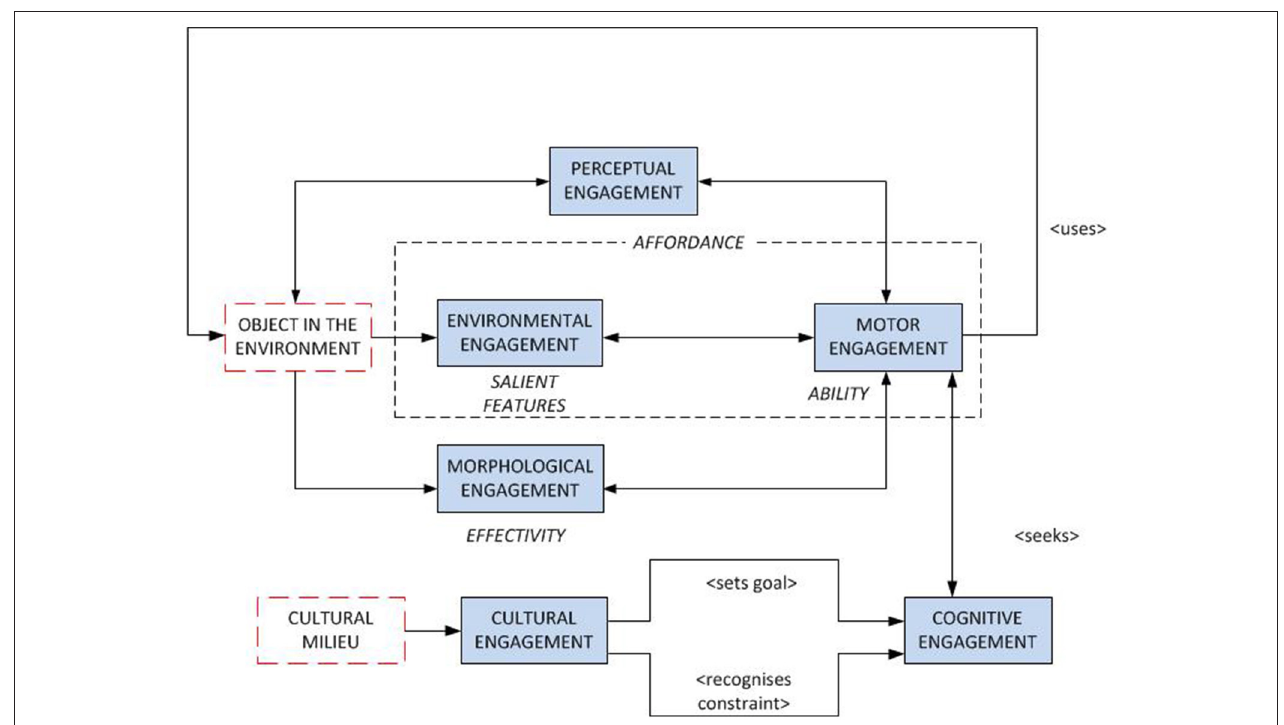
FIGURE 1 | Forms of Engagement (2017